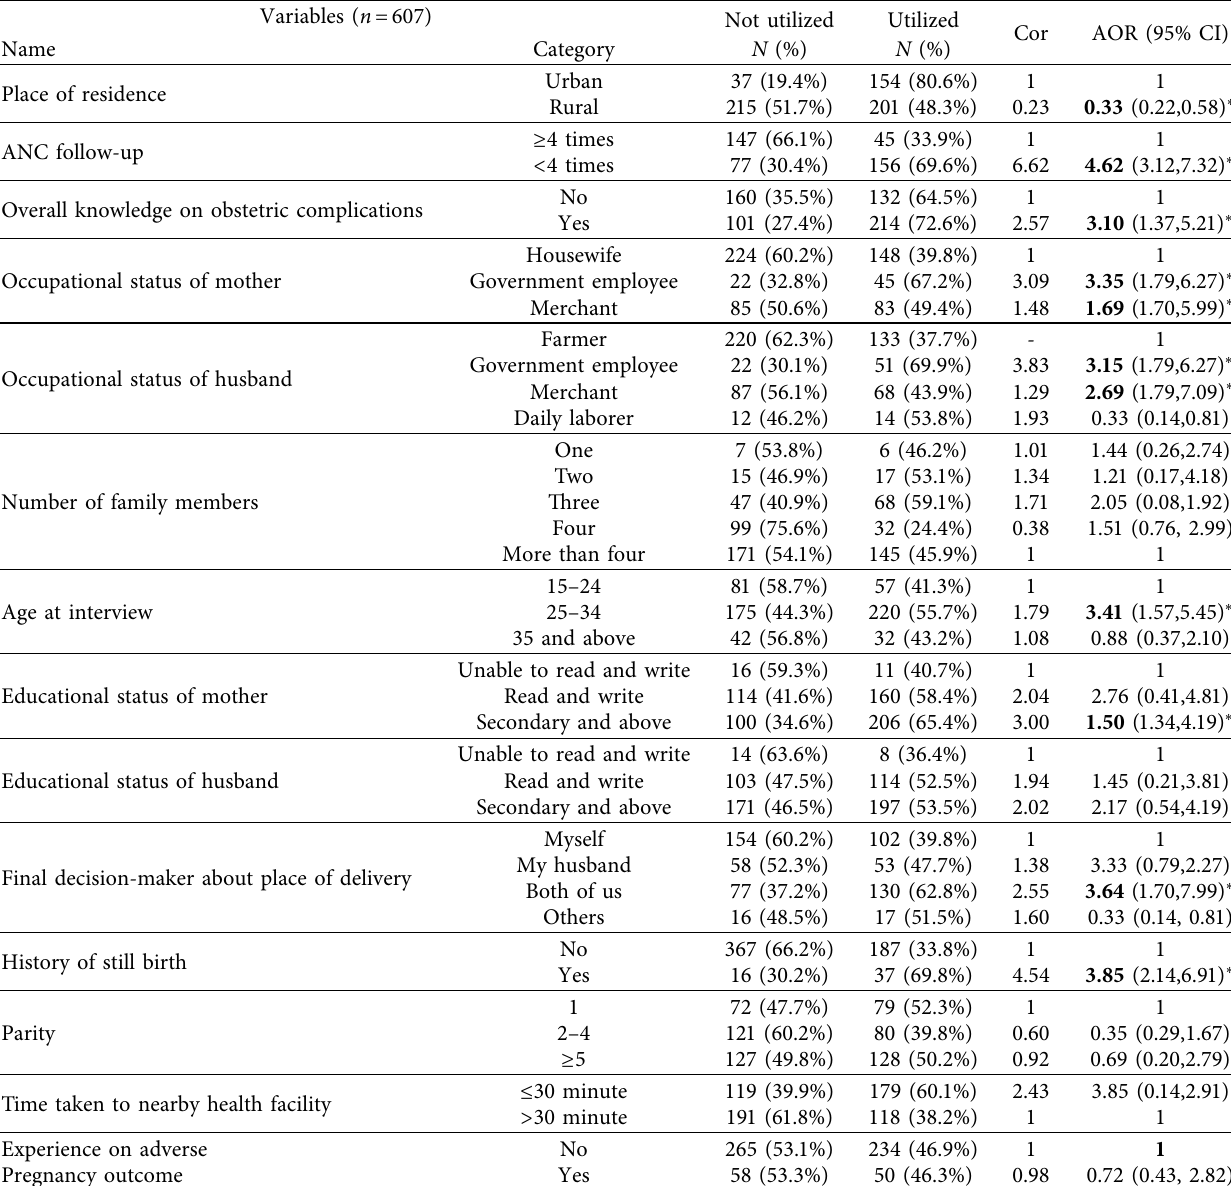
Table 5: Multivariable logistic regression analysis of factors associated with the utilization skilled birth attendance among mothers who gave birth in the past 12 months in the Kembata Tembaro zone, Southern Ethiopia,